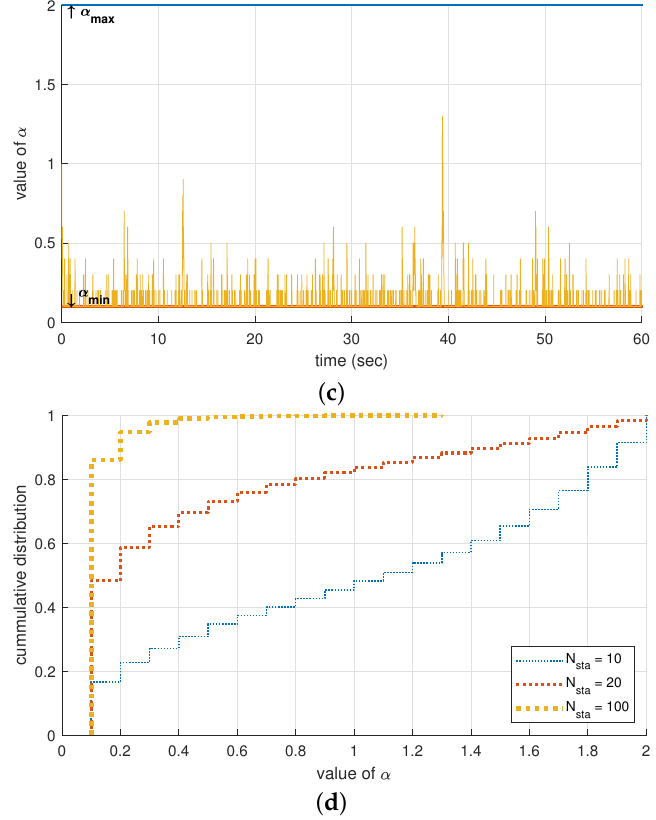
Figure 7. Observation of α when the number of contending STAs was ( a ) 10, ( b ) 20, and ( c ) 100, and ( d ) the cumulative distribution of α